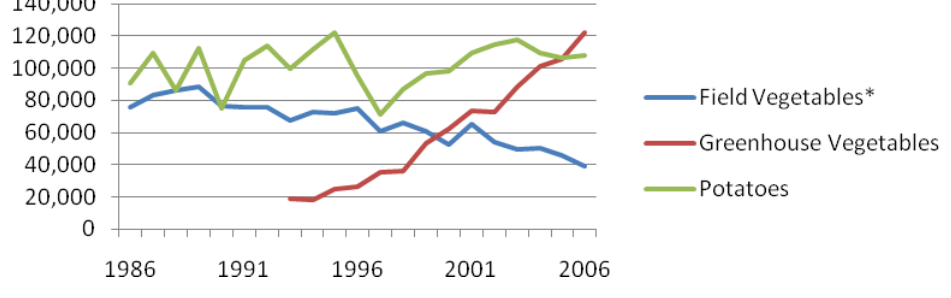
Figure 1. Tonnes of Vegetable Production in BC, 1986–2006.